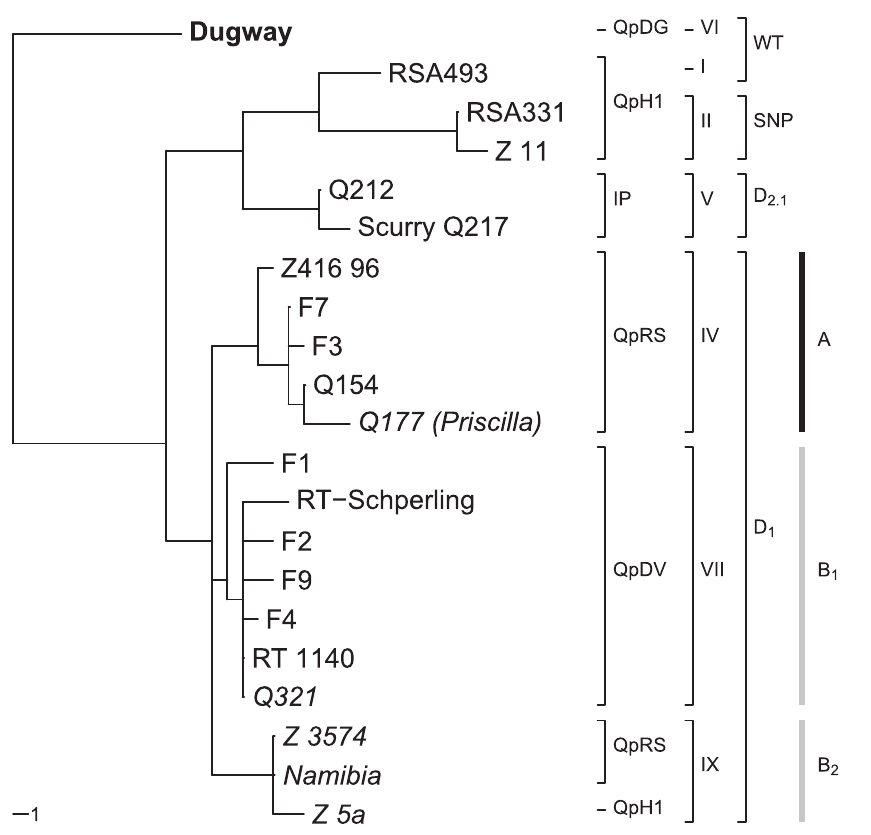
Figure 3. Phylogenetic relationship of studied strains. Maximum parsimony tree using 1,713 bases in the dataset computed with PAUP* and rooted using Dugway (bold) as outgroup. Plasmid type, genomic group (GG), adaA types and the subgroups of the Q154-deletion type are shown next to the tree. Branch lengths correspond to the number of mutations. Animal strains are written in italic. IP: integrated plasmid; WT: wildtype; D 2.1 : deletion 2.1; D 1 : deletion 1. The figure was drawn using APE [38].